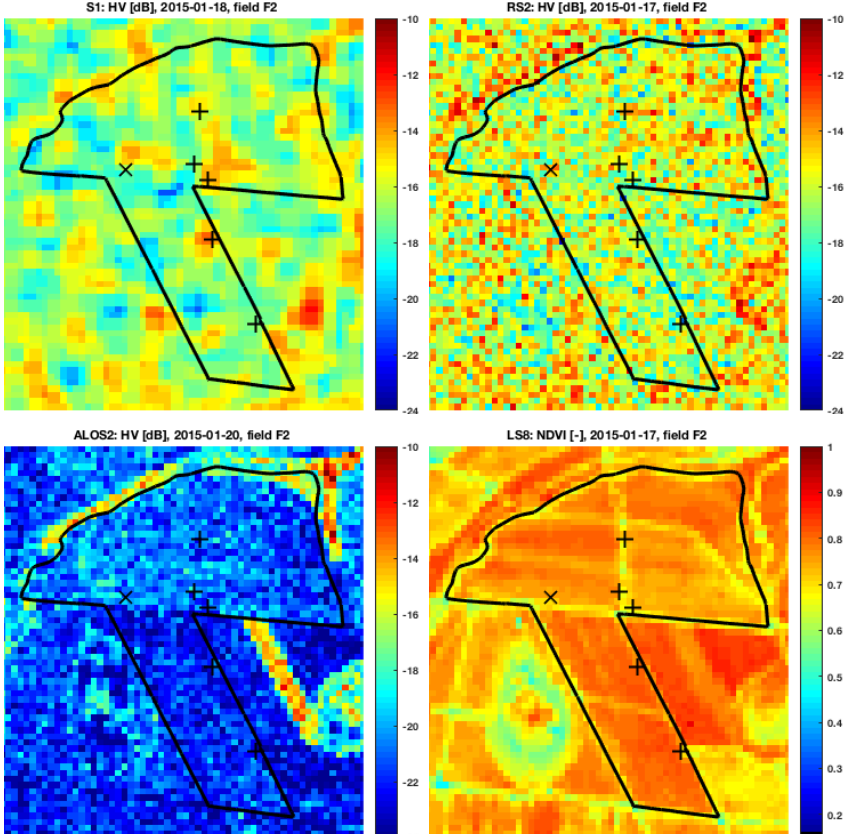
Figure 7. Sample images from available sensors, spatially averaged to 30 by 30 m pixel spacing, at approximately the same date for Field F2, around 100 days after start of growth, with a sugarcane height of 1 m. Plus signs (+) and crosses ( × ), location of ESUs and ESUs for biomass (ESUBs), respectively. North direction is up and field spans approximately 1.4 km northward by 1.7 km eastward.